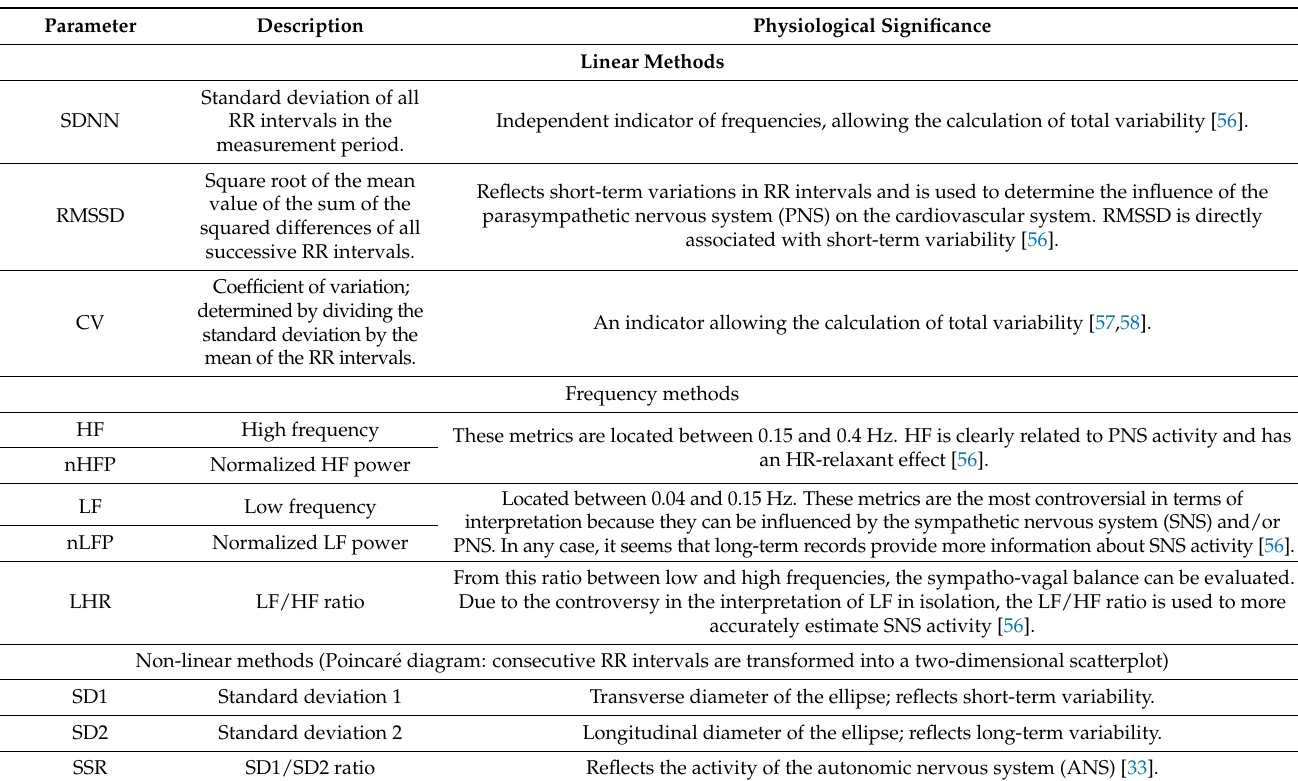
Table 1. Studied HRV